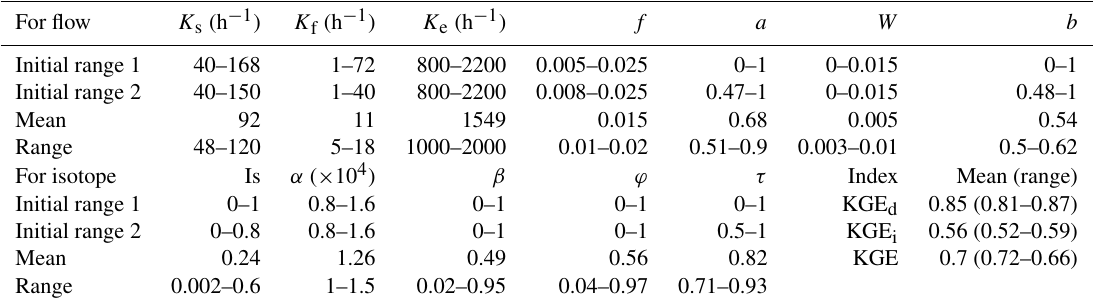
Table 2. Mean parameter values and fitness derived from the best 500 parameter sets after calibration. For flow K s (h − 1 ) K f (h − 1 ) K e (h − 1 ) f a W b Initial range